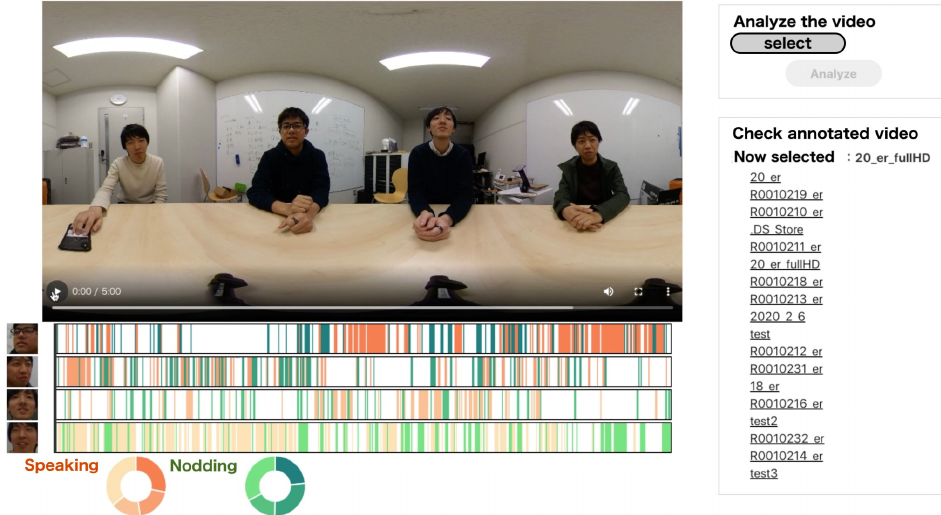
Figure 1. A screenshot of a meeting review system that utilizes our micro-behavior recognition. A user selects a video file, and the system classifies micro-behaviours in time